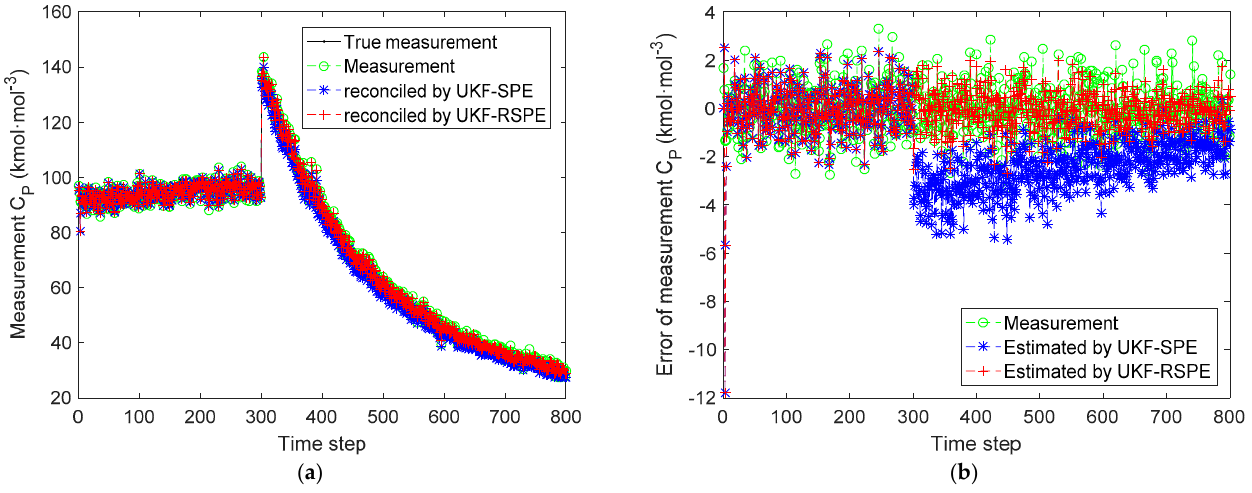
C in Case Study 2.2: ( a ) rec- p